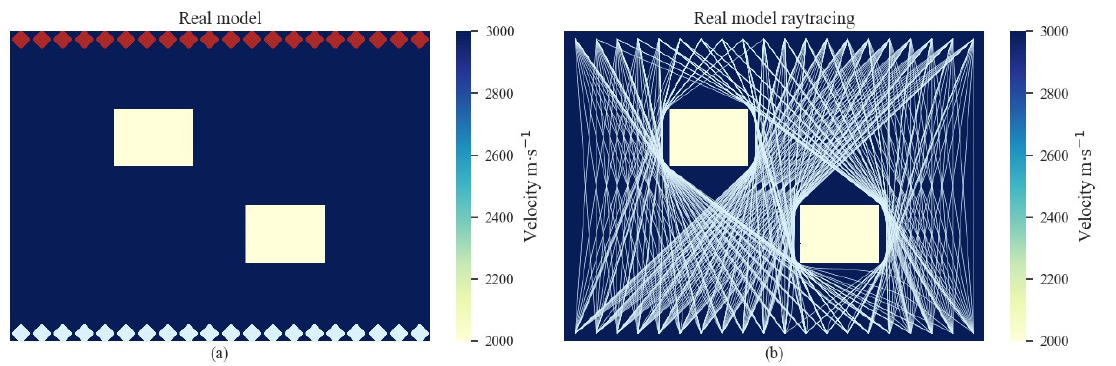
Figure 4. The real model ( a ) and its ray-tracing path ( b ) in the numerical experiments for multiple cavities. The red rhombuses represent the AE signal sources and the white rhombuses represent the receivers.